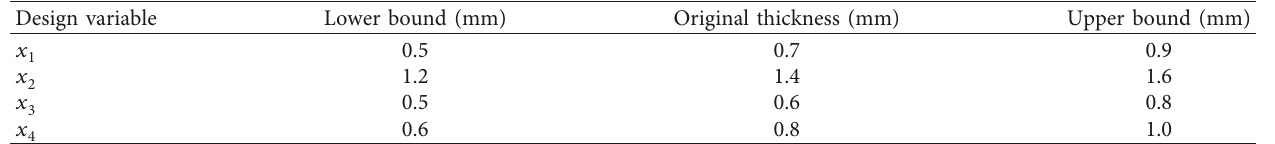
Table 3: Range of design variables of the corresponding panel. Design variable